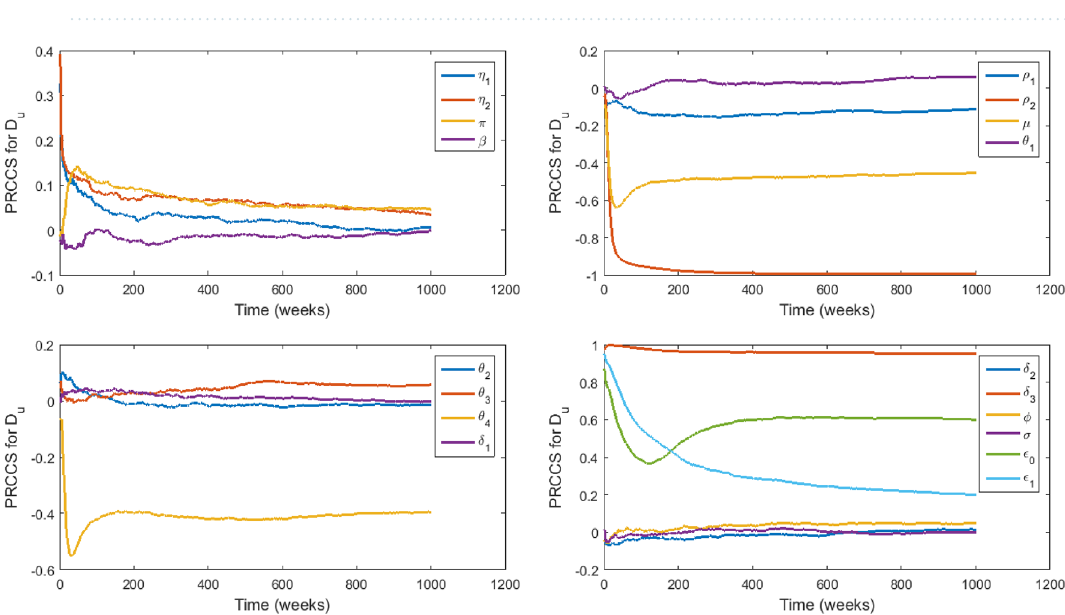
Figure 5. PRCC values of model (2)–(10) with Du as the response